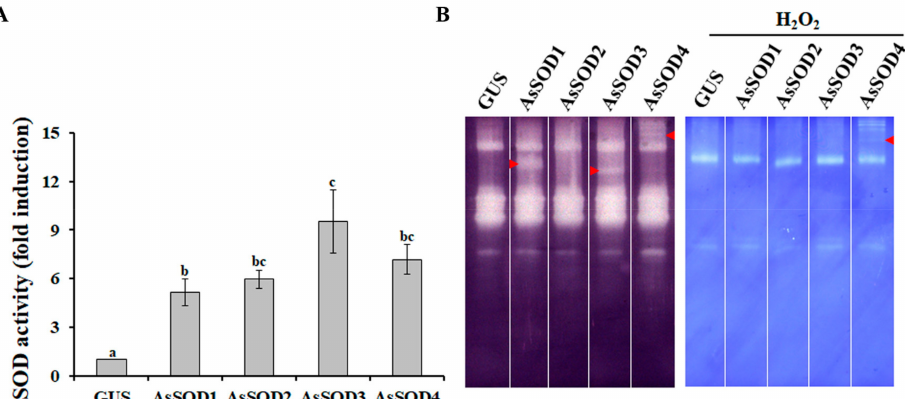
Figure 3. Functional characterization of putative garlic SODs (AsSODs) using the agro-infiltration assay. Total SOD activity ( A ) and activity pattern of SOD isozymes ( B ) were determined in N . ben- thamiana leaves infiltrated with Agrobacterium containing either each AsSOD overexpression construct or a GUS -overexpression construct (treated control). Arrows indicate a distinctive SOD activity band. The bars represent the mean ± SE across three independent experiments. Different letters indicate significant differences ( p <